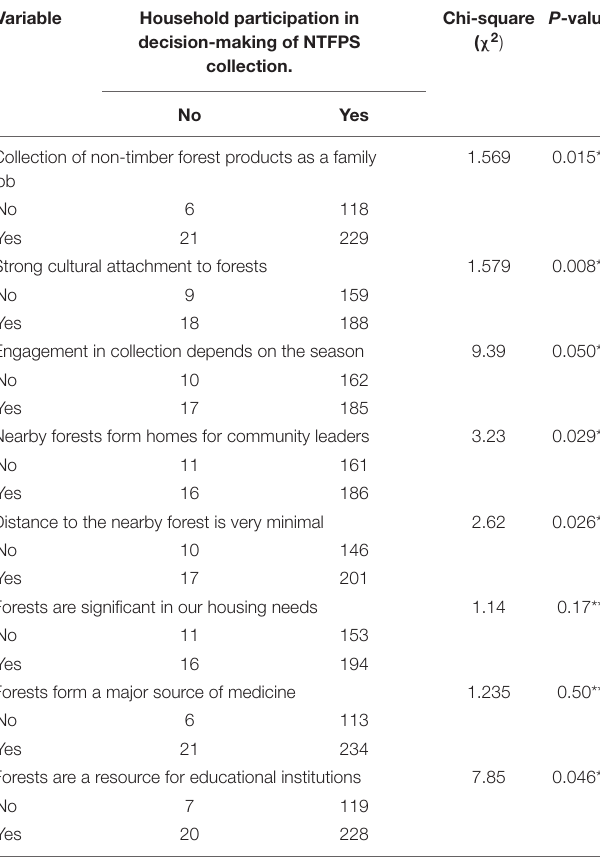
TABLE 2 | Social factors characterizing the dependence on non-timber forest products. Variable Household participation in decision-making of